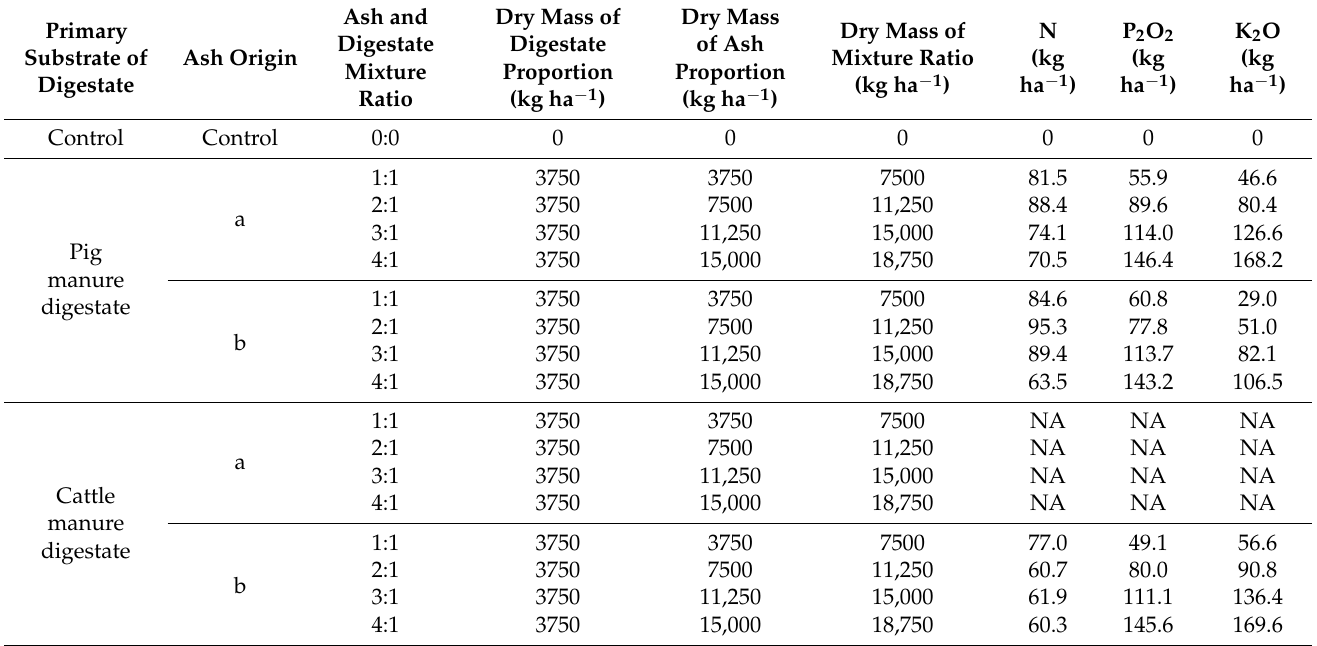
Table 1. Fertilisation norms and amount of NPK nutrients incorporated into the soil depending wood ash and digestate